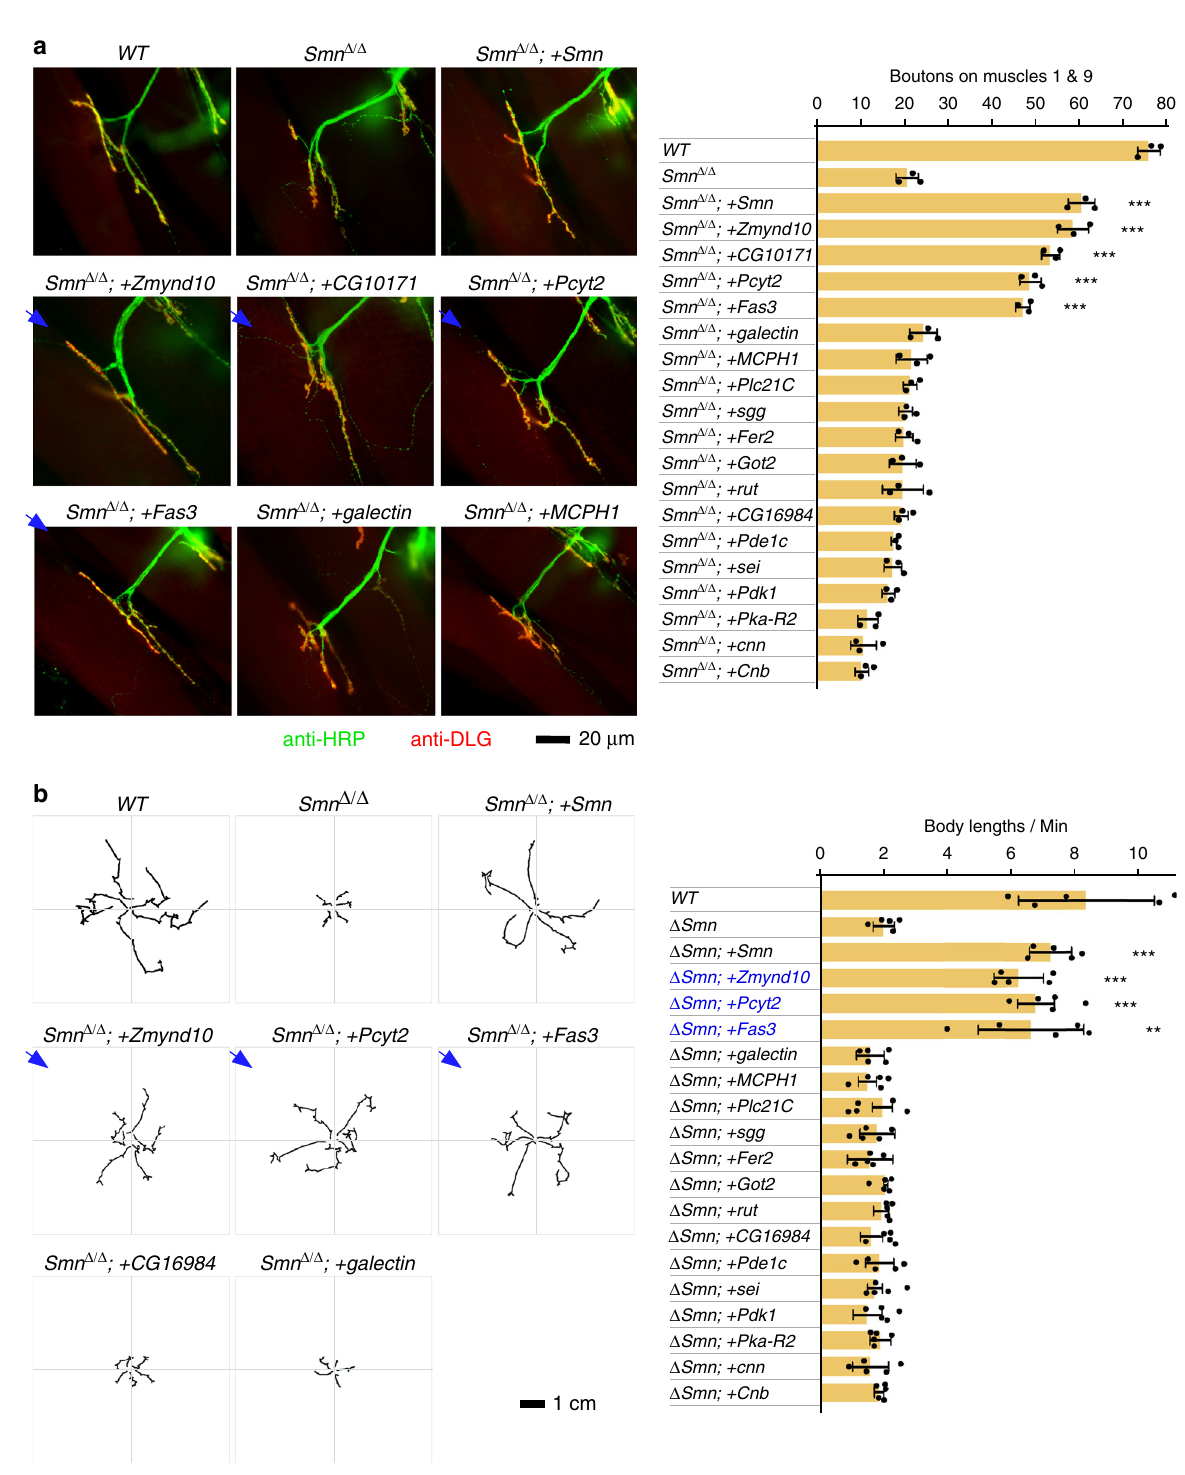
Fig. 3 Screen of neural genes that could rescue NMJ defects and larvae mobility. a Left, immunostaining of neuromuscular connections in transgenic strains driven by elav-GAL4 in the Smn Δ / Δ background. NMJ boutons are counted and the additional transgenic strains are shown in Supplementary Fig. 5a. Right, quantitation of boutons in each strain ( Smn Δ / Δ ; + Smn : p = 8.3e-5; Smn Δ / Δ ; + Zmynd10 : p = 0.00021; Smn Δ / Δ ; + CG10171 : p = 8.3e − 5; Smn Δ / Δ ; + Pcyt2 : p = 0.00017; Smn Δ / Δ ; + Fas3 : p = 0.00025). b Left, larval locomotion of transgenic strains ( Smn Δ / Δ ; + Smn : p = 8.1e − 6; Smn Δ / Δ ; + Zmynd10 : p = 0.0001; Smn Δ / Δ ; + Pcyt2 : p = 9.3e − 5; Smn Δ / Δ ; + Fas3 : p = 0.00442). Additional transgenic strains are shown in Supplementary Fig. 5d. Right, quantitation of path length of larval locomotion. Data represent the mean ± SD from fi ve representatives of each strain. ** p < 0.01, *** p < 0.001. P values were calculated using two-sided t -test. Source data are provided as a Source Data fi